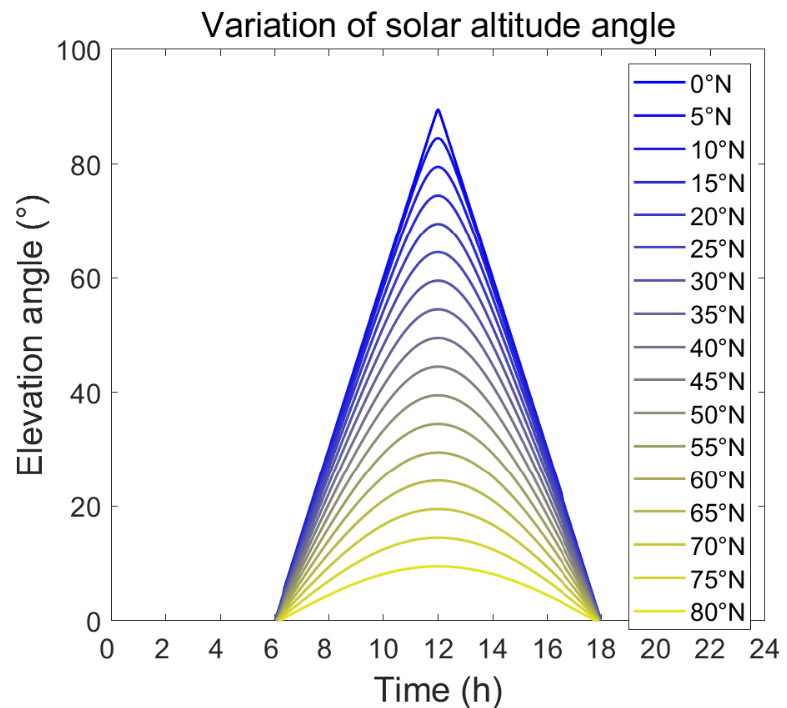
Figure 7. The variation of the solar altitude angle at the meridian of 37° E at the 2019 vernal equinox. The different curves indicate the daily variation of the Sun’s tilt angle with different latitudes. The horizontal coordinates indicate the time of day, the vertical coordinates indicate the solar tilt angle, and the legends indicate the different latitudes.